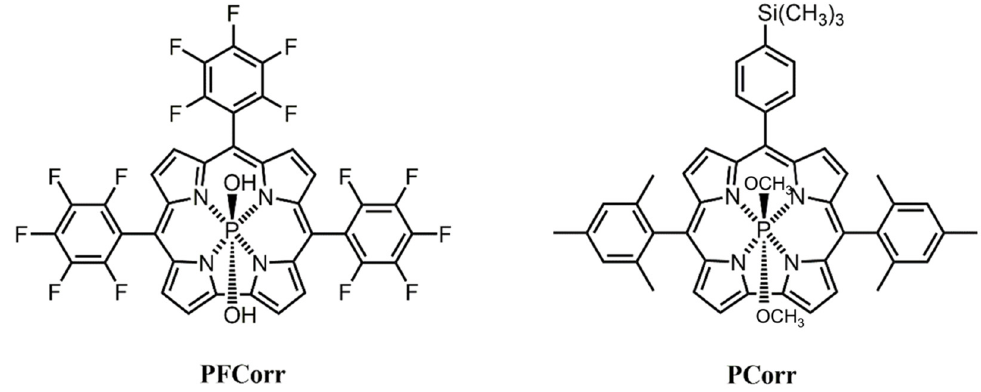
Figure 1. Chemical structures of studied phosphorous (V) corroles fluorophores.